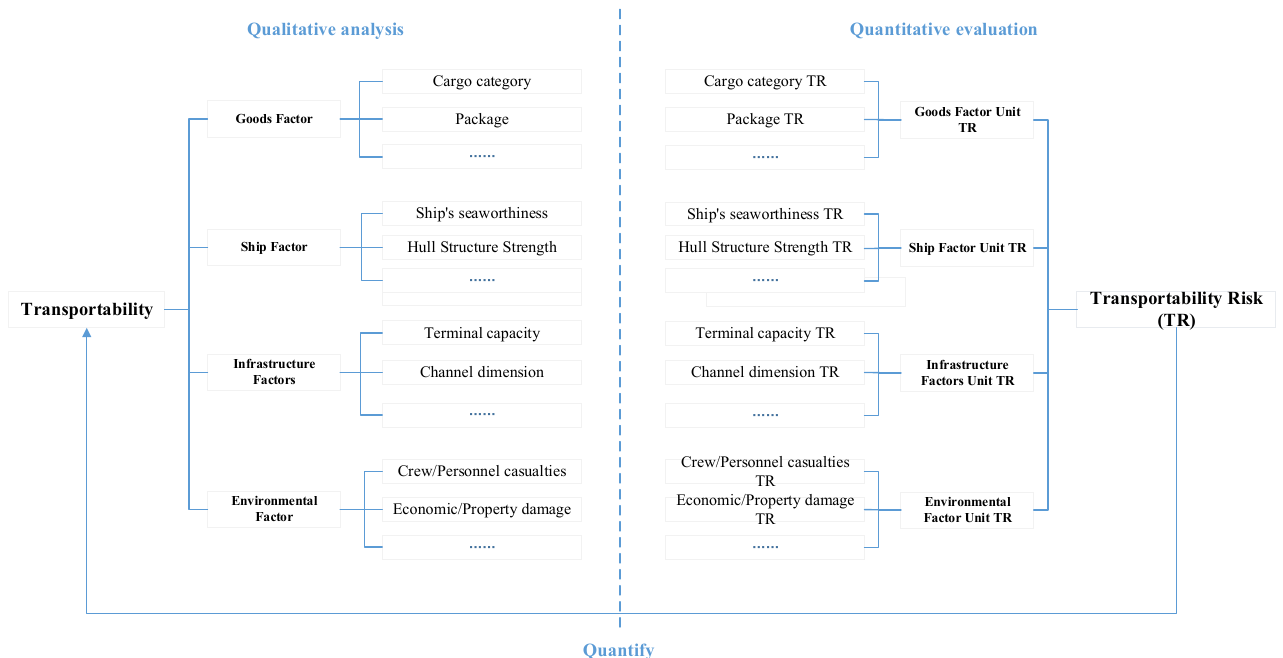
Figure 2. Overview of the Principles of Transportability Evaluation.